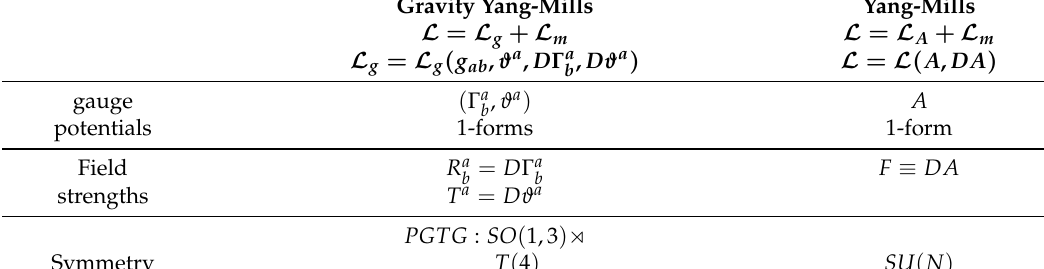
Table 3. The analogies between Yang-Mills fields and gravity-Yang-Mills theory in the language of exterior forms. Gravity Yang-Mills